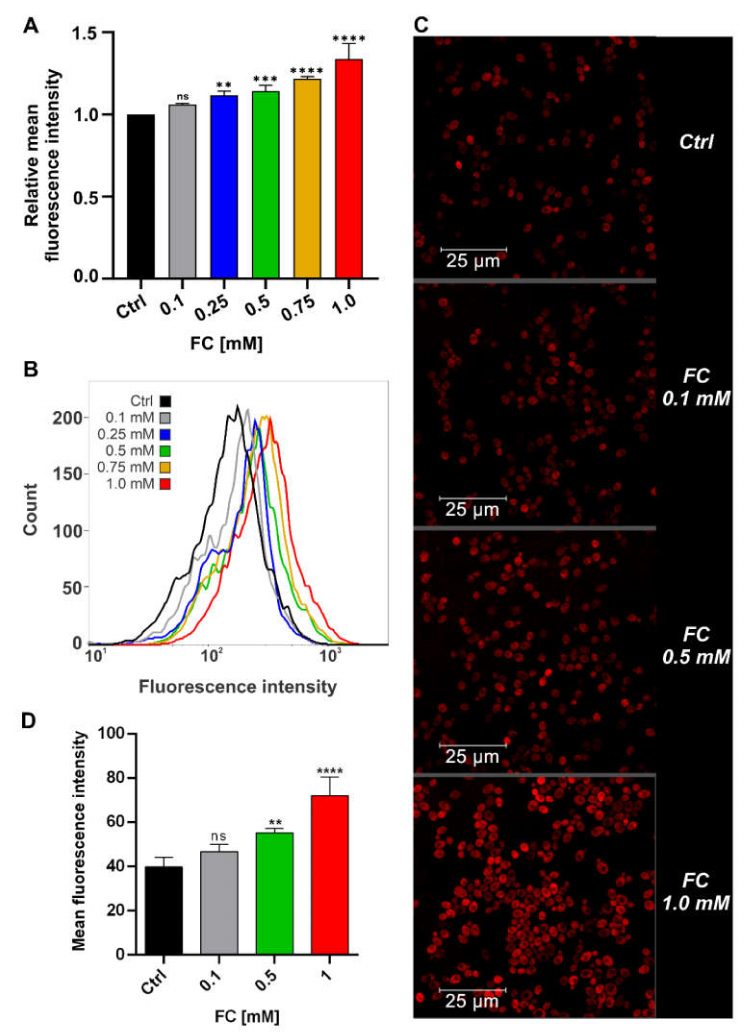
Figure 6. MMP ( ∆Ψ m) changes in yeast cells growing in YPG medium supplemented with 0.1, 0.25, 0.5, 0.75, or 1.0 mM FC. ( A , B ) Flow cytometry analysis using TMRE staining. Bar graph ( A ) presents relative mean fluorescence intensity ± SD, whereas histogram ( B ) presents the data from at least three independent experiments. ( C , D ) Confocal microscopy analysis of ∆Ψ m using TMRE staining (ex/em: 543/570–610 nm). Representative images ( C ) and fluorescence intensity changes ( D ) in yeast cells treated with 0.1, 0.5, or 1 mM FC. Data are presented as mean fluorescence intensity ± SD of three independent experiments. Statistical significance versus control (ANOVA): (ns) non − significant, (**) p < 0.01, (***) p < 0.001, (****) p <